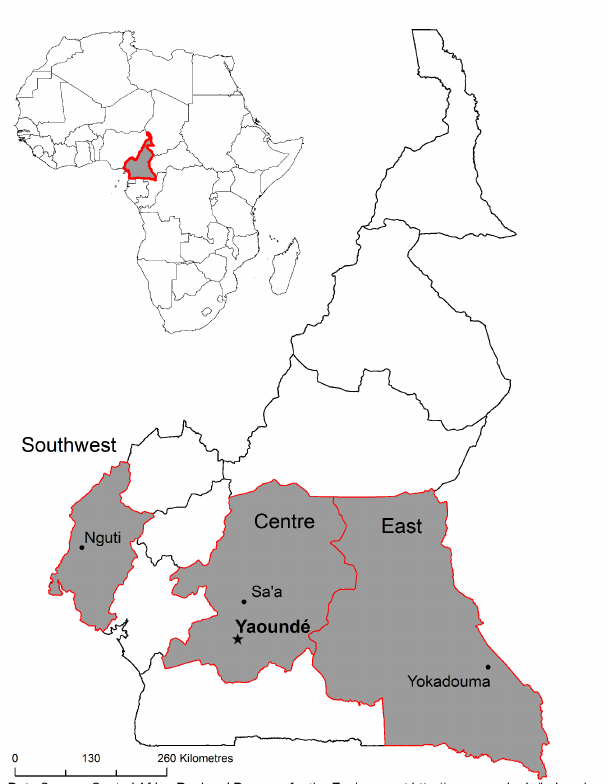
Fig. 1 . Location of research areas in Cameroon.